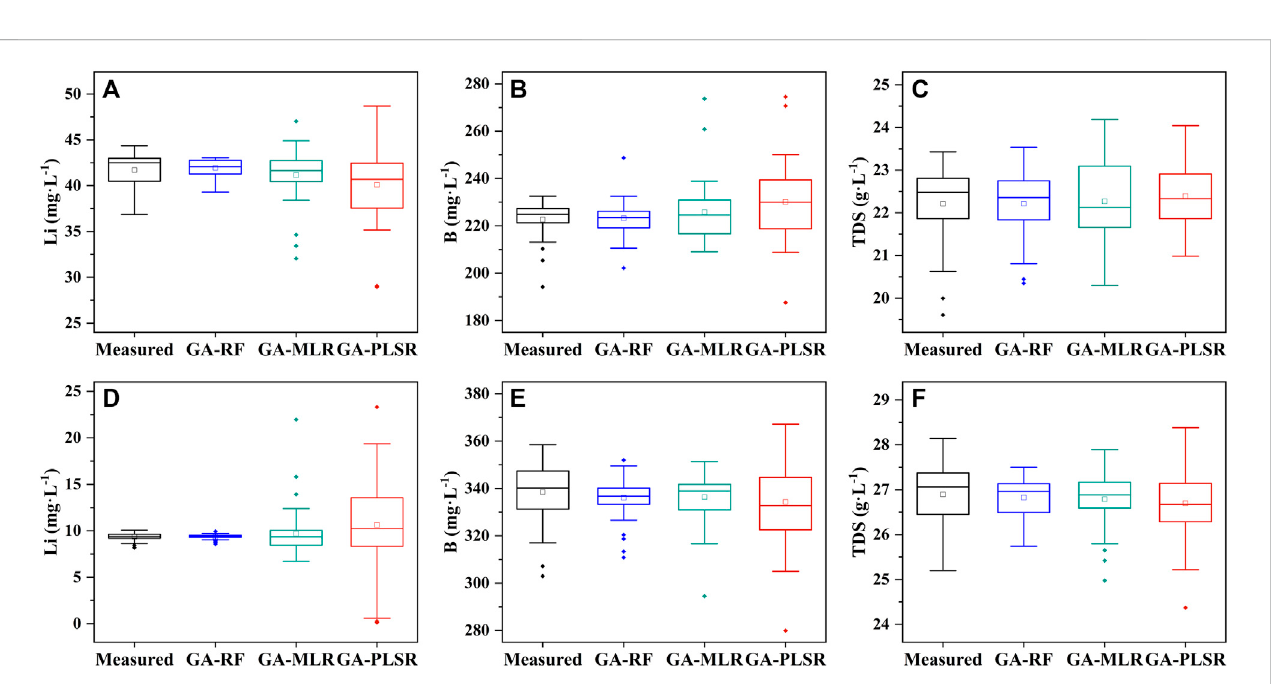
FIGURE 12 Boxplotsof fi eldmeasurementsandthreemodelestimatesofLi,B,andTDScontents. (A) , (B) and (C) indicatethemeasuredandmodelestimatesofLi,B, and TDS contents of Bieruoze Co, respectively. (D) , (E) and (F) indicate the measured and estimated values of Li, B, and TDS contents of Guopu